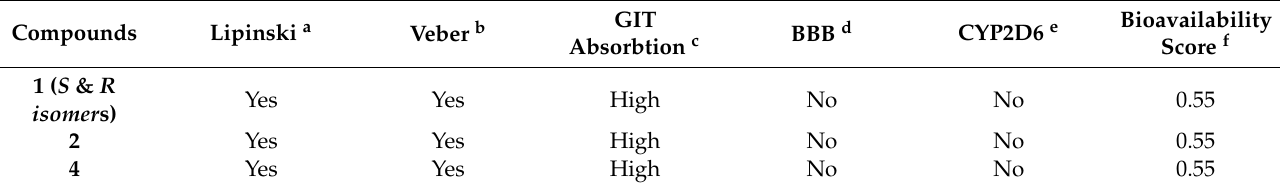
Table 2. Predicted ADME profiles of the M pro